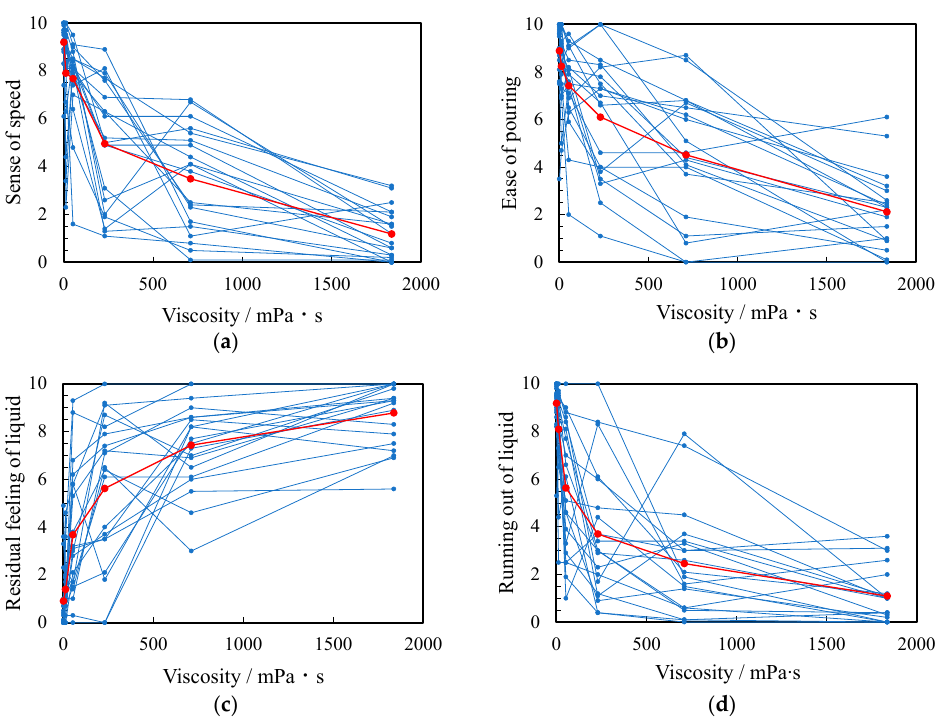
Figure 3. Relationship between viscosity and score of ( a ) ease of pouring, ( b ) sense of speed, ( c ) residual feeling of liquid, and ( d ) running out of the liquid. The score for all subjects and their arithmetic mean are plotted as small blue and large red circles, respectively.